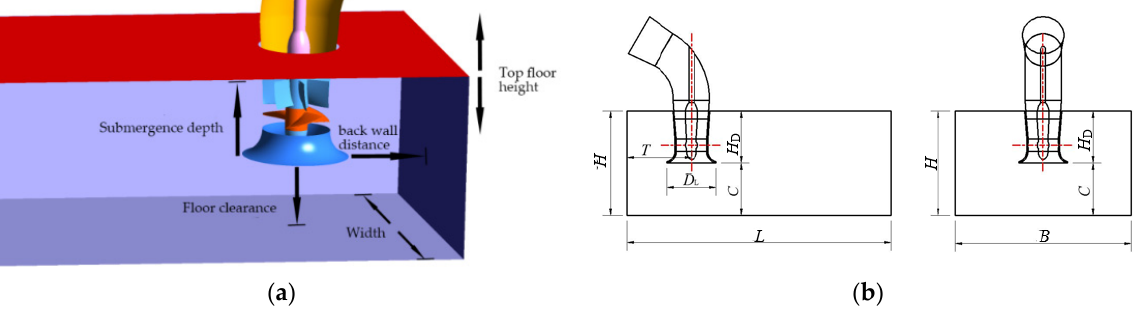
Figure 5. 3D model and geometric parameters. ( a ) 3D model and ( b ) geometric parameters.